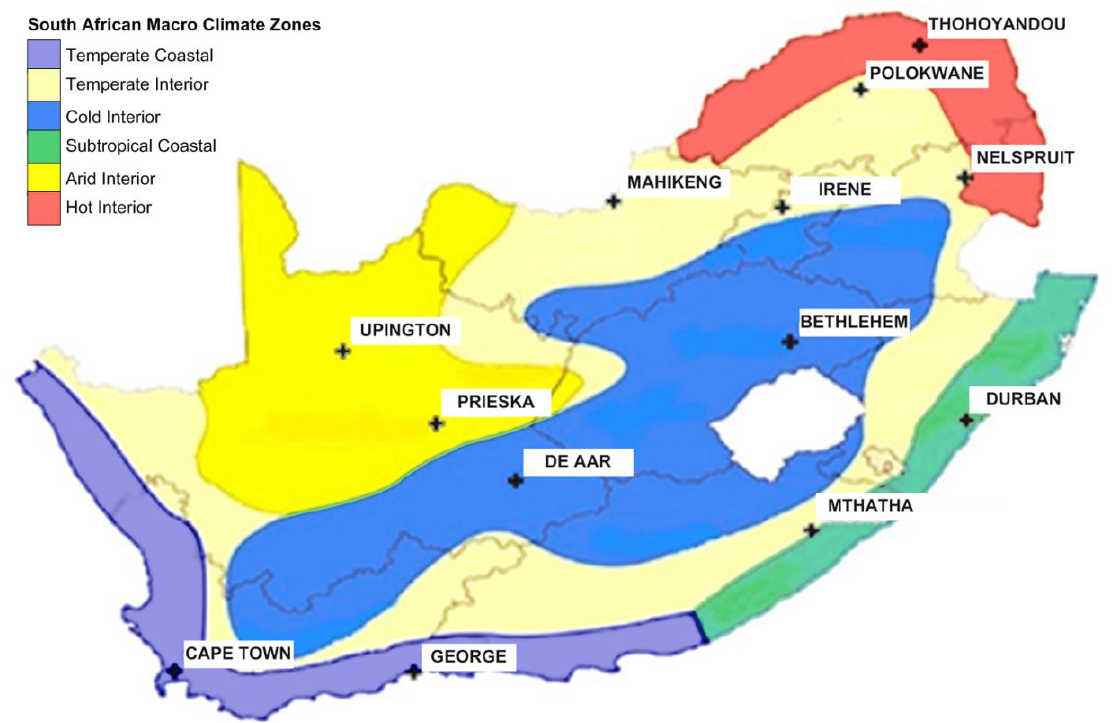
Figure 1. A map showing South African Weather Service’s radiometric station location and climatic zones (Adapted from Mabasa et al., 2020 [57]).